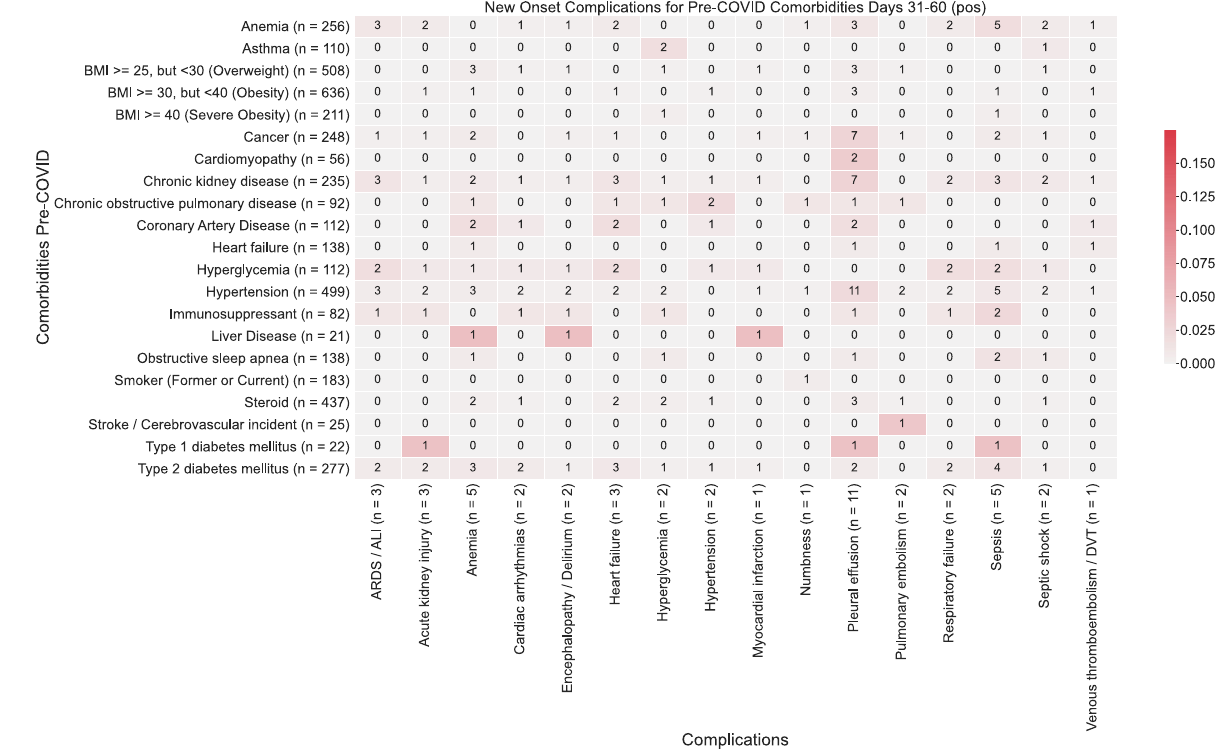
Fig. 3 Heatmap showing associations between comorbidities and late-onset complications (31 – 60 days post-PCR) in COVID-19 patients. The color of each (comorbidity, complication) pair corresponds to (number of patients with the comorbidity that had the complication for the fi rst time in the time window (31 – 60 days))/(total number of patients with the comorbidity). Darker shades of red correspond to higher rates of complications, and lighter shades of red correspond to lower rates of complications. A patient is determined to have comorbidity if it is recorded in their clinical notes with positive sentiment any time before their fi rst positive PCR test. For each comorbidity row and for each complication column, the number of patients is shown in